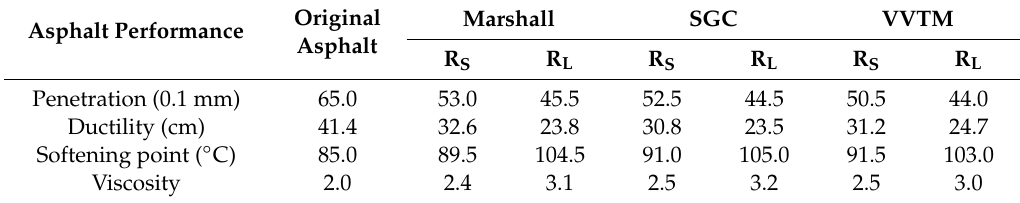
Table 14. Influence of aging process on the performance of asphalts designed by di ff erent methods. Asphalt Performance